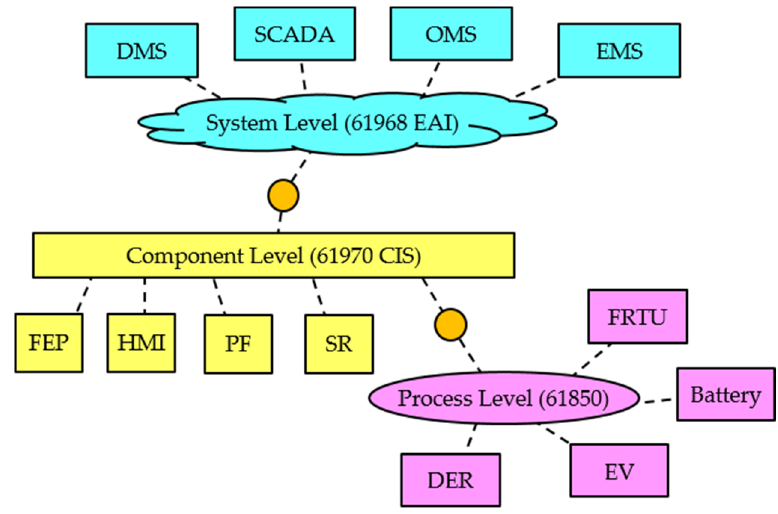
Figure 4. The applicable subjects of the interoperability.